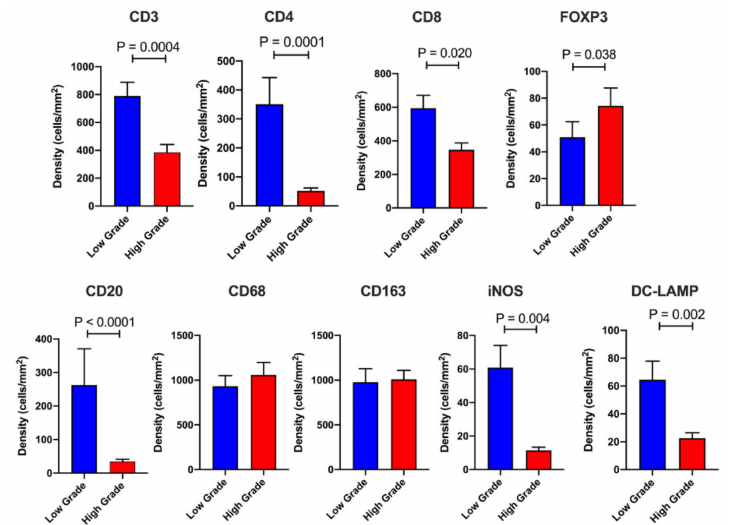
Figure 3. Stromal (S) immune profiling. Barplots displaying the S leukocyte density in High Grade ( n = 54) versus Low Grade ( n = 57) tumor budding cases. The following immune cell markers were utilized (CD3, CD4, CD8, FOXP3, CD20, CD68, iNOS, CD163, DC-LAMP). Data are depicted as mean + SE. Differences between groups were analyzed using the Mann-Whitney U test. Only significant P values are shown on the